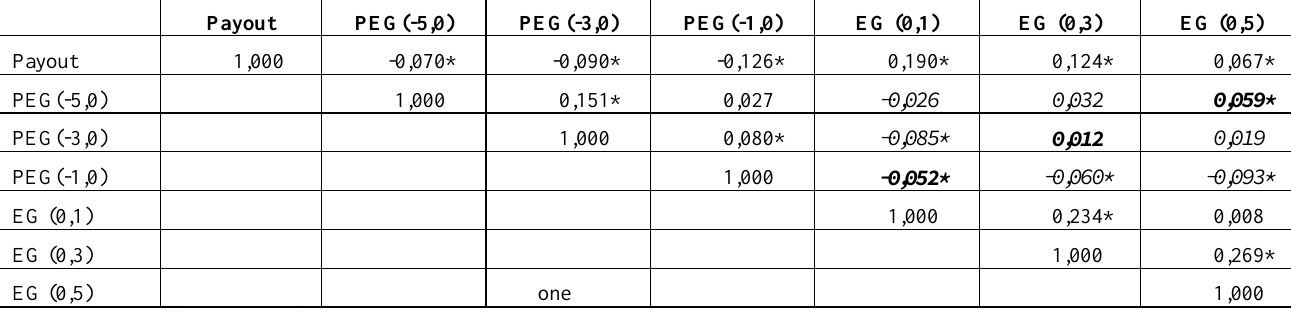
Table 4: Correlations between dividend payout, past and future earnings growth (SA)